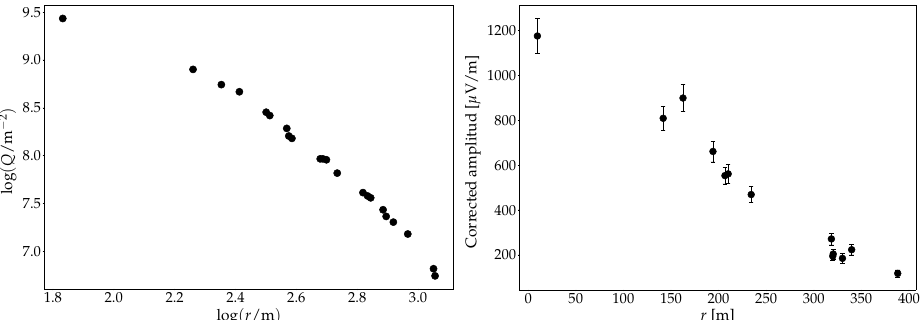
Figure 6. Left : Logarithmic photon density as function of the logarithmic distance to the shower axis (lateral distribution function) of an event measured by the non-imaging Cherenkov detectors of Yakutsk. The primary energy and zenith angle of the event are: E ∼ = 1.3 respectively. Adapted from [50]. Right : Lateral distribution function, after asymmetry correction, of an event measured by the Tunka radio antennas in the 35–76 MHz band. Adapted from